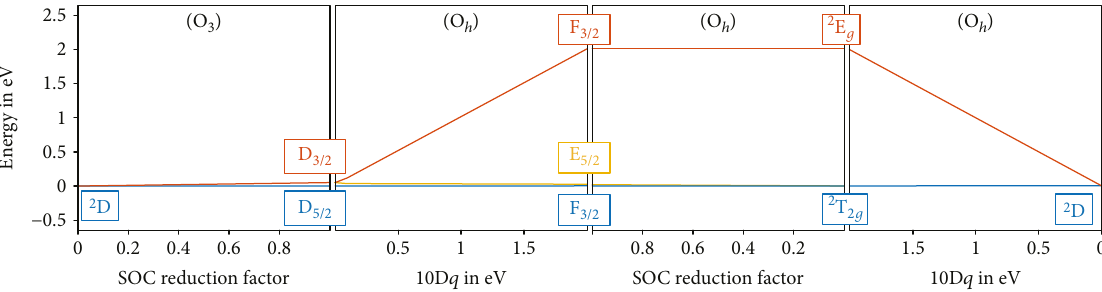
crystal fi eld 10D q on the splittings of the h